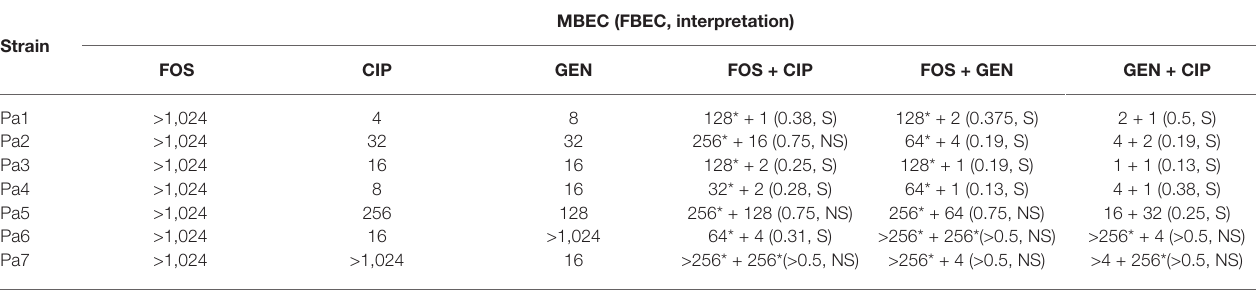
MBEC (FBEC, interpretation)